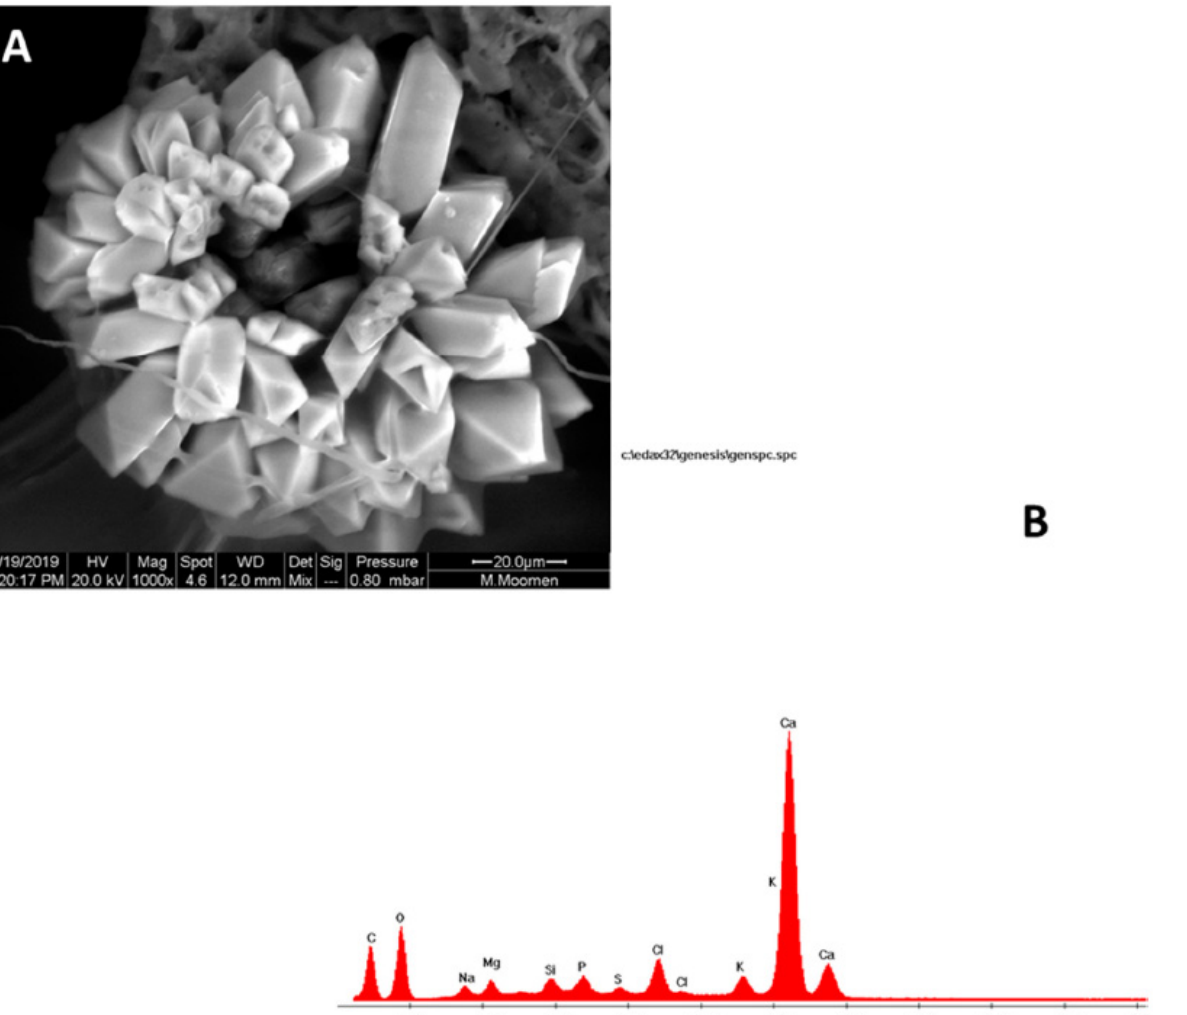
Figure 10. Druse crystal in the vascular system of grapevine visualized by ESEM imaging ( A ): Detail of a dense globular shape with a ring of elements appearing like rose petals or glass flakes. Note the presence of some needle raphide ( B ): X ray showing a spectrum of cells with crystal. The type of crystal is presumably calcium oxalate which showed large Ca, minor C and O peaks, and traces of many other elements.